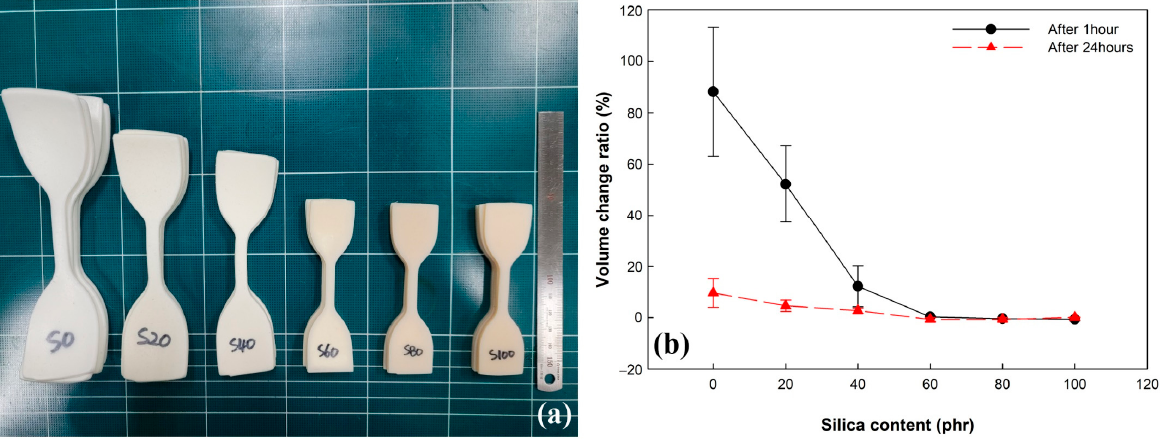
Figure 6. Effects of silica content on the volume changes of EPDM after exposure to 96.3 MPa of hydrogen gas for 24 h: ( a ) the image immediately after decompression and ( b ) volume changes after decompression.